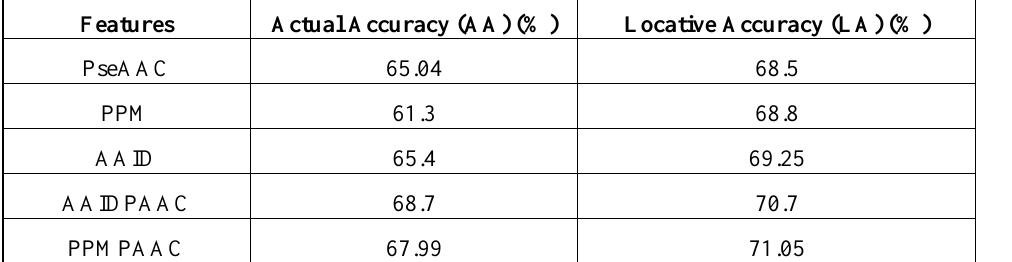
Table 3: Performance for different features using